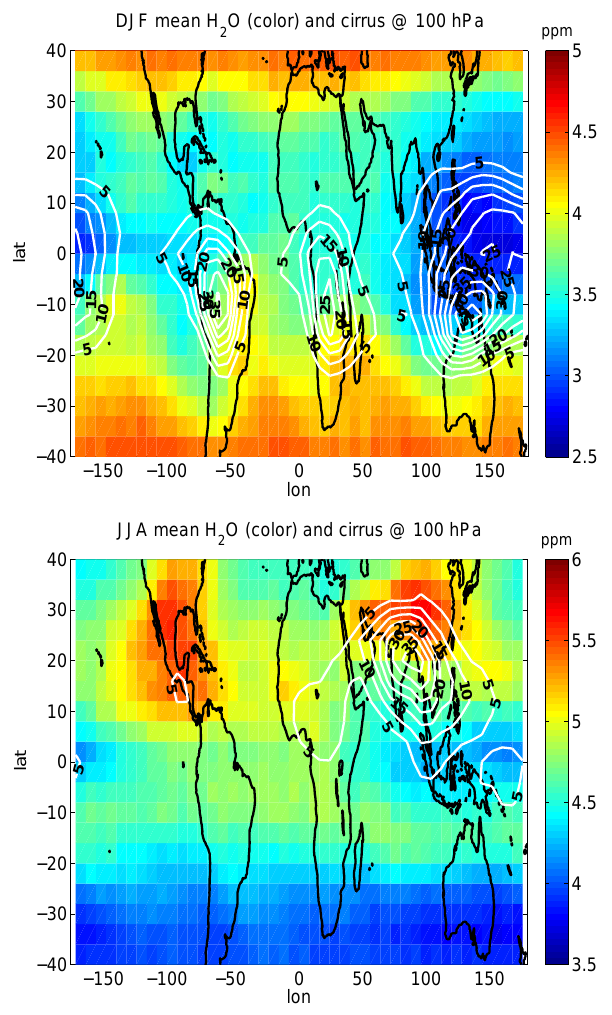
Fig. 2. Seasonal average of cirrus cloud fraction (contours in %) and water vapor (color) at 100hPa in DJF (top) and JJA (bottom). Maximum cirrus cloud fraction occurs in DJF at the same time as minimum water vapor values, especially over Indonesia. During JJA water vapor is high and cirrus shift northward into the monsoon regions.